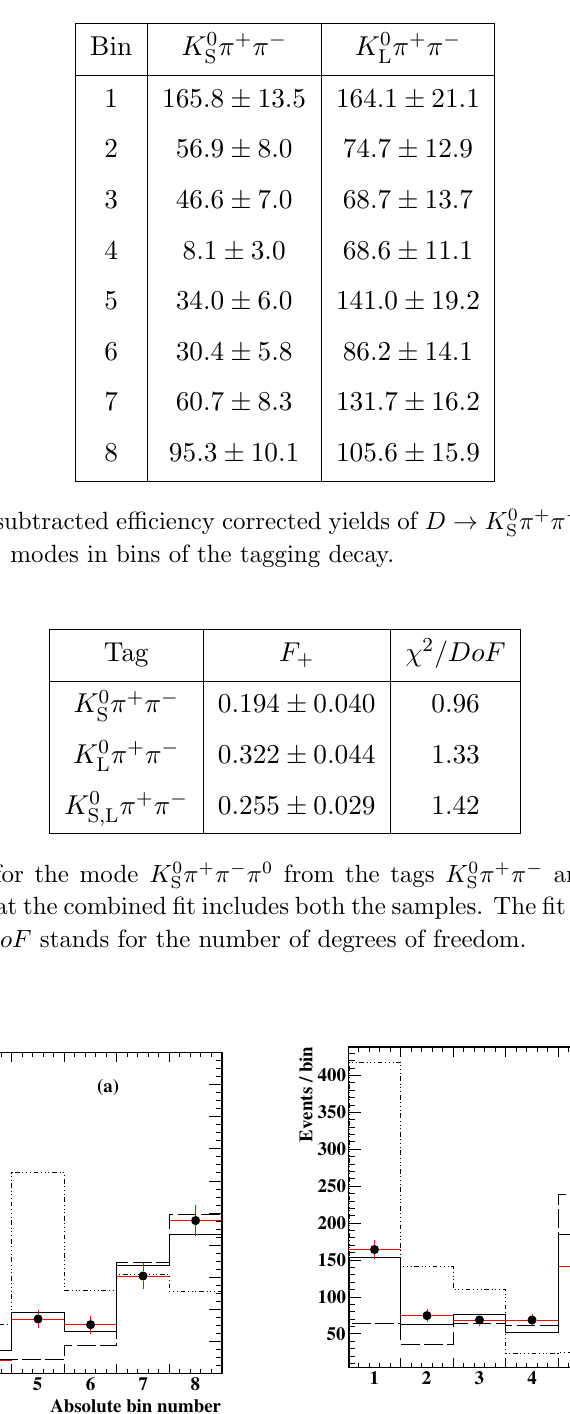
Figure 9 . Predicted and measured yields for (a) K 0 from the combined (cid:12)t of both the modes. The histogram shows the predicted values from the (cid:12)t, points show the measured values, the dashed line corresponds to F + = 0 and the dotted line shows F + =